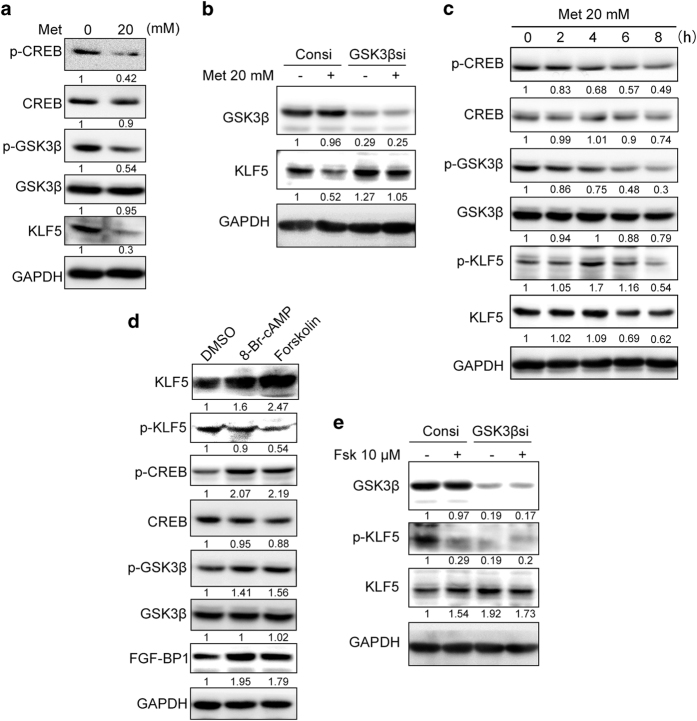
Metformin and PKA regulate the KLF5 protein level through GSK3β. (a) Metformin decreased the phosphorylation of GSK3β at S9. HCC1937 cells were treated with metformin (20 mM) for 24 h. The protein levels of p-GSK3β (S9), p-CREB and KLF5 were measured by WB. (b) GSK3β knockdown blocked the metformin-induced decrease in KLF5 expression. HCC1937 cells were transfected with either GSK3βsi or control siRNA (Consi) for 48 h. Then, the cells were treated with metformin (20 mM) for an additional 24 h. (c) Metformin (20 mM) decreased the protein levels of p-CREB (S133), p-GSK3β (S9) and KLF5 in HCC1937 cells in a time-dependent manner. HCC1937 was treated by 20 mM metformin for 0, 2, 4, 6 and 8 h. The cells were collected for WB to detect the p-CREB (S133), p-GSK3β (S9), p-KLF5 (S303) and KLF5 expression. (d) HCC1937 cells were treated with either 8-Br-cAMP (1 mM) or forskolin (10 μm), which are PKA activators, and both increased p-GSK3β (S9) and decreased the p-KLF5 (S303) protein levels. The treatment duration was 24 h. The cells were collected for WB to detect the p-CREB (S133), p-GSK3β (S9), p-KLF5 (S303), KLF5 and FGF-BP1 expression. (e) GSK3β knockdown blocked the forskolin (10 μm)-induced KLF5 increase in HCC1937 cells. The cells were transfected with GSK3βsi or Consi for 48 h, which was followed by the addition of forskolin for another 24 h. The cells were collected for WB to detect the GSK3β, p-KLF5 (S303) and KLF5 expression.